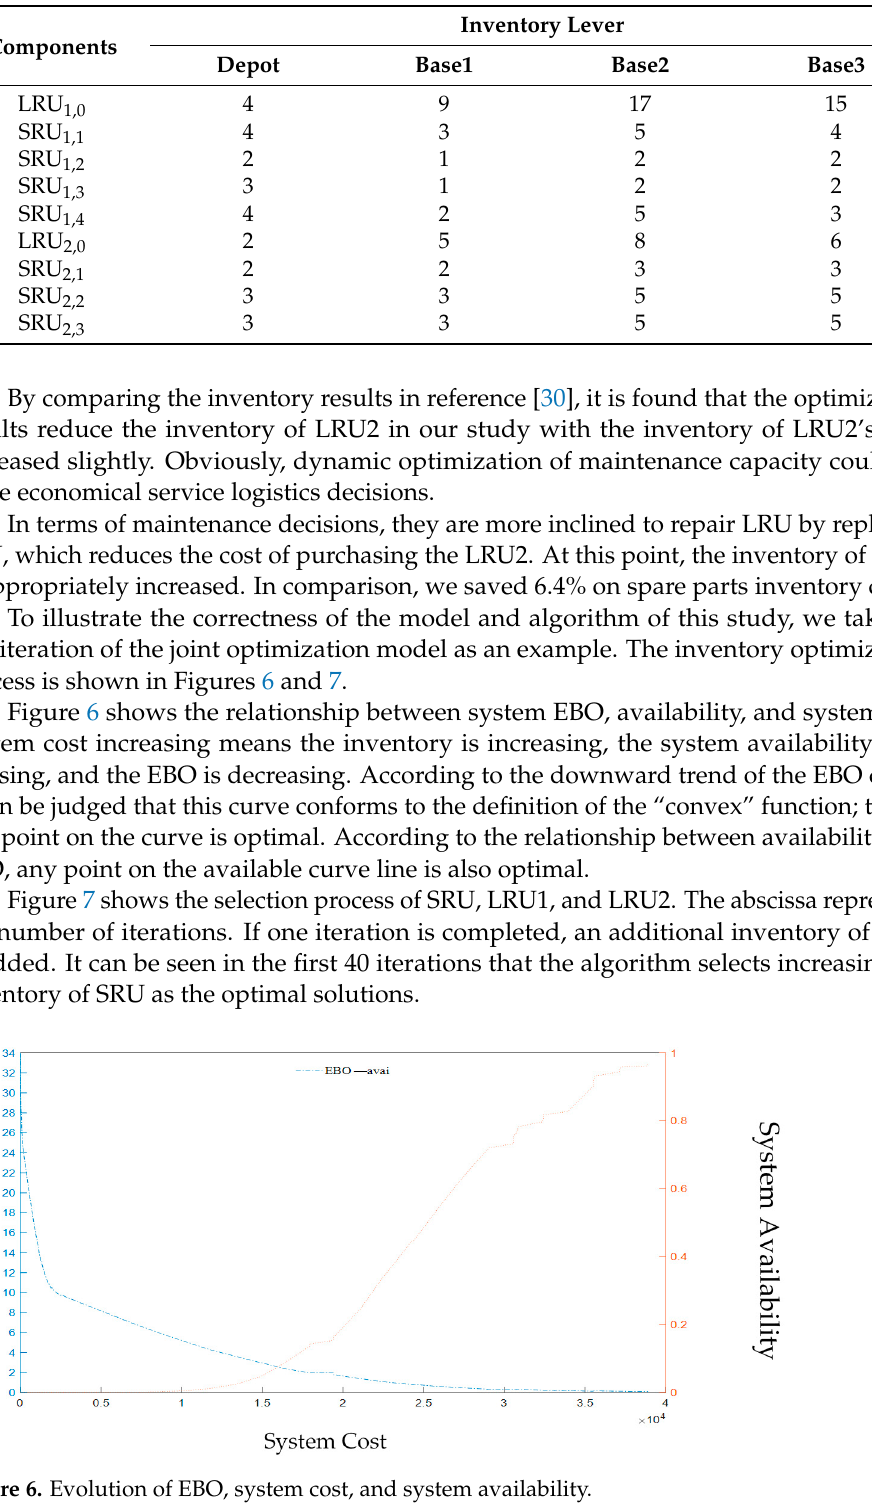
Table 2. Inventory optimization results.